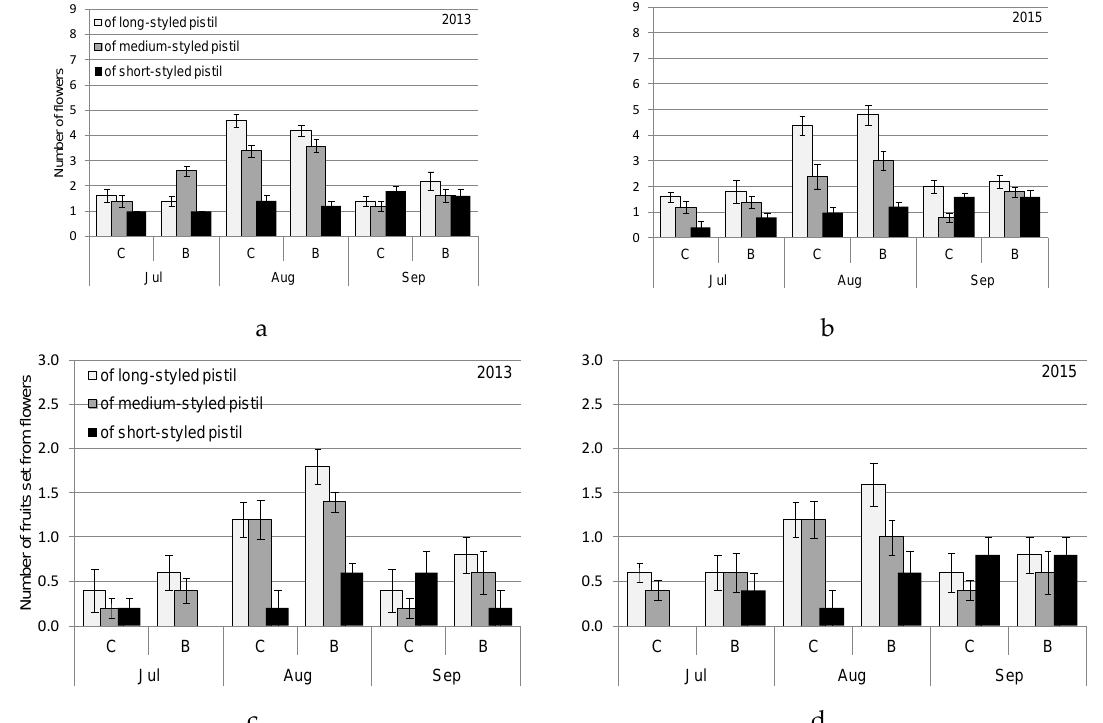
Figure 8. The course of flowering and fruit setting of “Gascona” F 1 eggplant as depended on fruit type and biostimulant treatment. C, control; B, biostimulant. Bars represent mean number of flowers per plant in 2013 ( a ), 2015 ( b ) and fruits per plant in 2013 ( c ), and 2015 ( d ) (error bars indicate SE). Table 5. Results of ANOVA for parameters of flowering and fruit setting of “Gascona” F 1 eggplant presented in Figure 8.